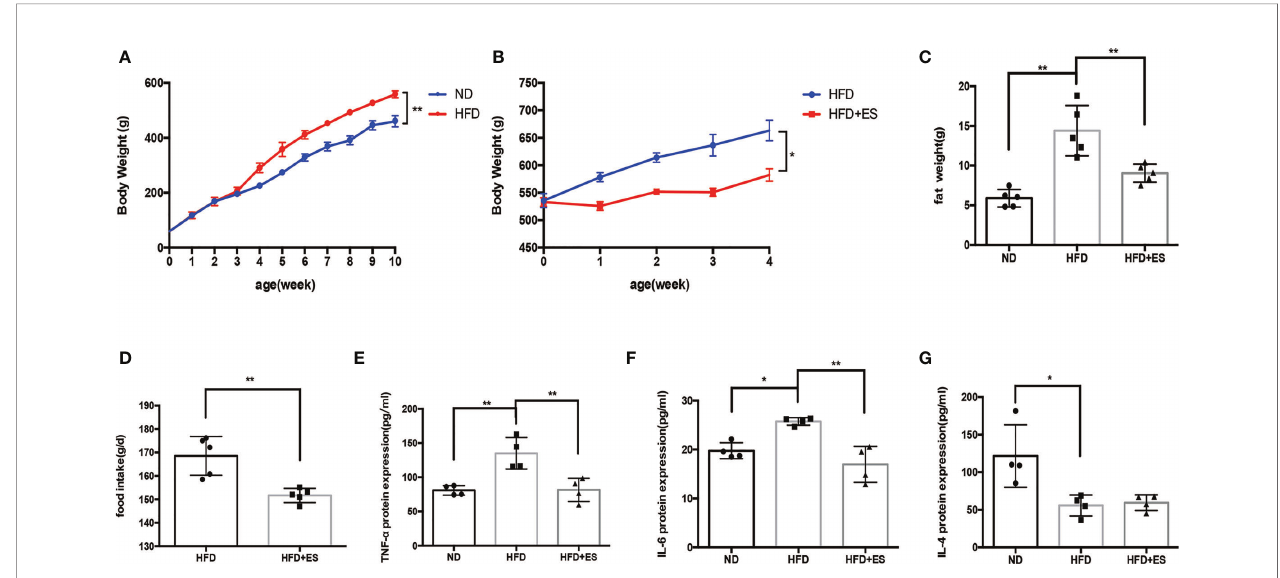
FIGURE 1 | Effect of ES on body weight, adipose weight, and in fl ammatory state. (A) Bodyweight of rats from the normal diet (ND) and high-fat diet (HFD) groups after 10 weeks (n = 5, ** P < 0.01). (B) Bodyweight of HFD rats with or without ES during 4 weeks after feeding for 10 weeks (n = 5, * P < 0.05). (C) The weight of eWAT in the ND, HFD, and HFD + ES groups (n = 5, ** P < 0.01). (D) Food intake of HFD and HFD+ES mice. Data are shown as average food intake per day from 4 weeks of ES (n = 5, ** P < 0.01). (E) Relative TNF- a expression in serum (n = 4, ** P < 0.01). (F) Relative IL-6 expression in serum (n = 4, * P < 0.05, ** P < 0.01). (G) Relative IL-4 protein expression in serum (n = 4, * P <